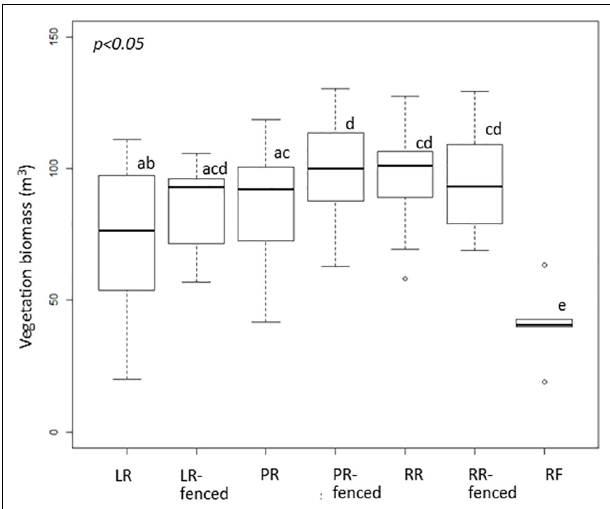
FIGURE 3 | Boxplot of vegetation biomass below the deer line in each treatment after windthrow and in the mature, natural mixed forest. Significant differences according to a permutation test ( p < 0.05) are indicated by different letters. LR, legacy retention; LR-fenced, LR enclosed by a deer fence; RR, residual rows; RR-fenced, RR enclosed by a deer fence; PR, planting rows; PR-fenced, PR enclosed by a deer fence; and RF, mature, natural mixed forest (reference